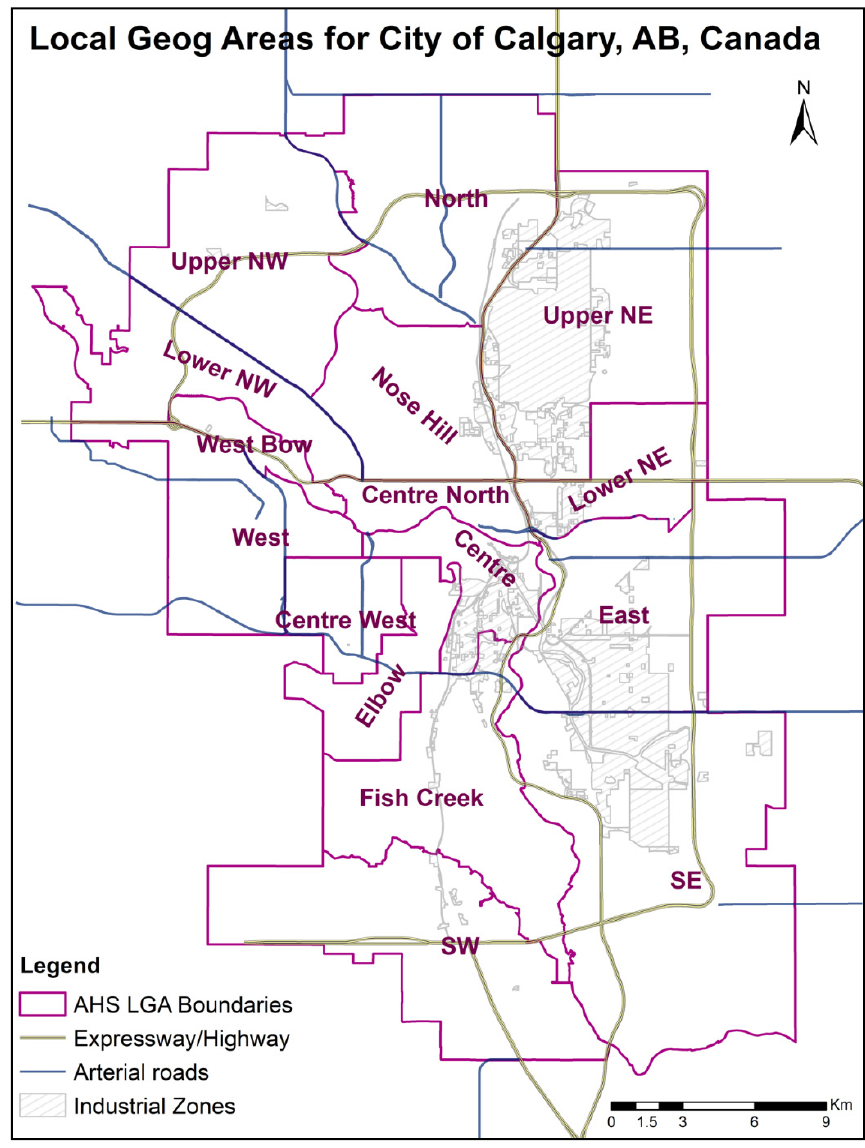
Figure 1. Study area overview showing the Alberta Health (AHS) Local Geographic Areas (LGAs).